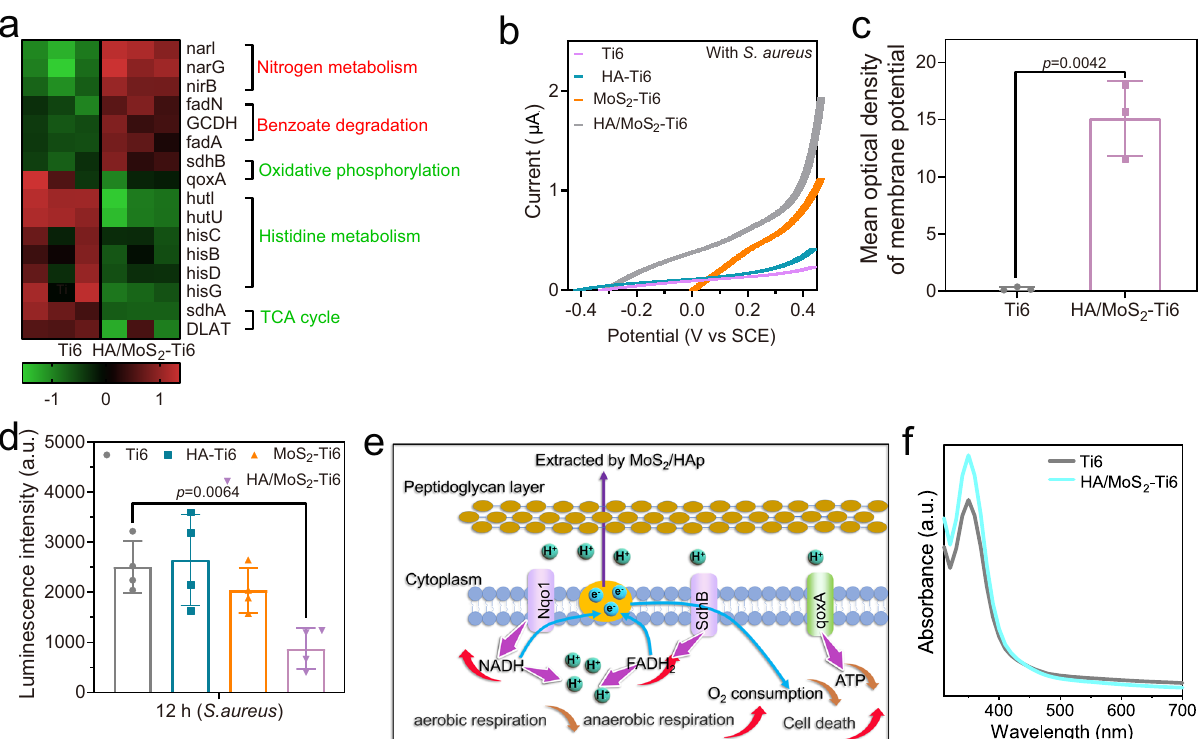
Fig. 4 HA/MoS 2 -Ti6 extracted electrons from bacteria. a Expression change of the nitrogen metabolism, benzoate degradation, oxidative phosphorylation, histidine metabolism, and TCA cycle between Ti6 and HA/MoS 2 -Ti6. b LSV curves of different samples without bacteria ( S. aureus ). c Mean optical density of bacterial membrane potential of Ti6 and HA/MoS 2 -Ti6. ( n = 3 independent samples). d ATP level of S. aureus adhered on different samples for 12 h in the dark presenting the bacterial metabolic activity intensity. ( n = 4 independent samples). e Complete process of S. aureus activated by HA/MoS 2 -Ti6 for further stimulating bacterial death. f Oxygen concentration of S. aureus with different treatment presenting the bacterial metabolic state. c, d Data represented as mean ± standard deviations from a representative experiment. Error bar represents the standard deviation. p- values were analyzed by one-way ANOVA with Dunnett ’ s multiple comparison test. Source data are provided as a Source Data fi